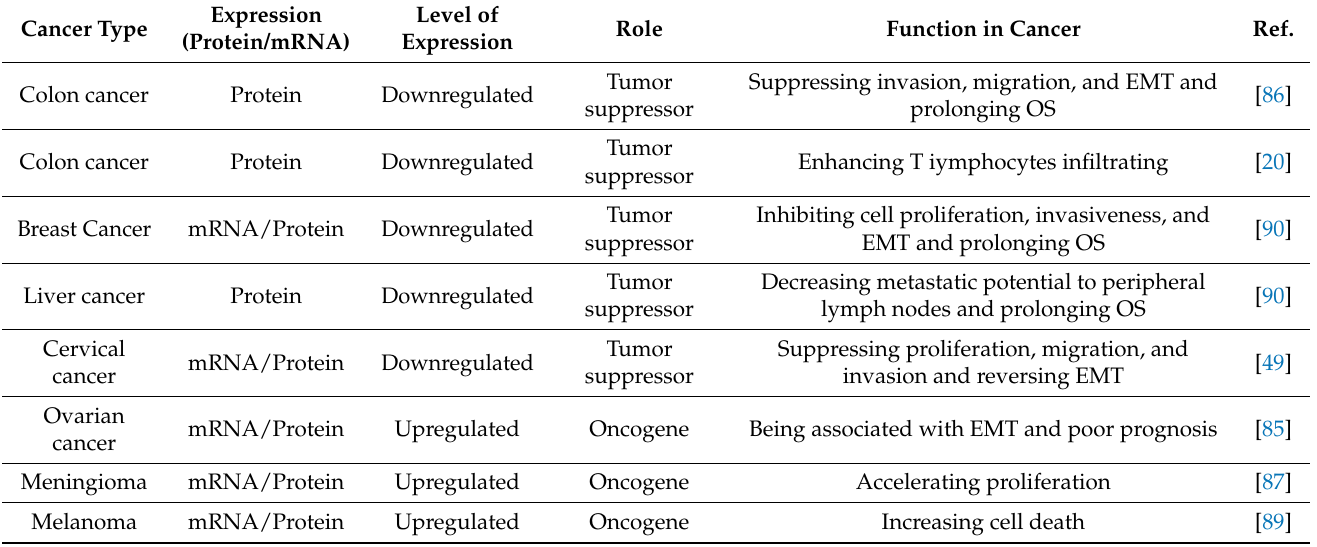
Table 1. The role of OGN in